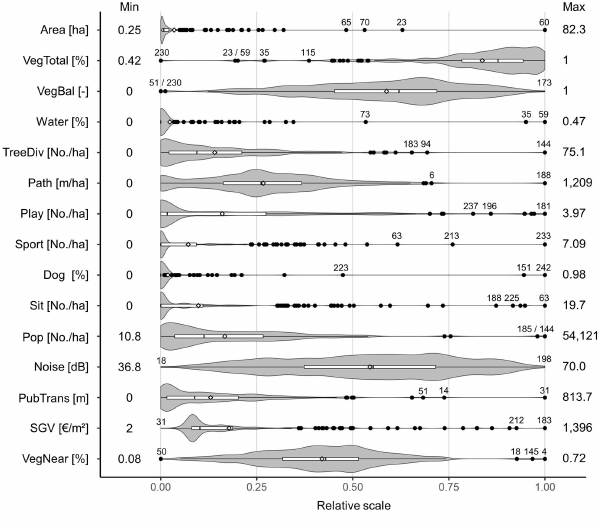
Fig. 5 . Violin plots for selected indicators (5 per dimension) with boxplots (white bars, median as vertical black line, whiskers as horizontal black lines), and mean value indicators